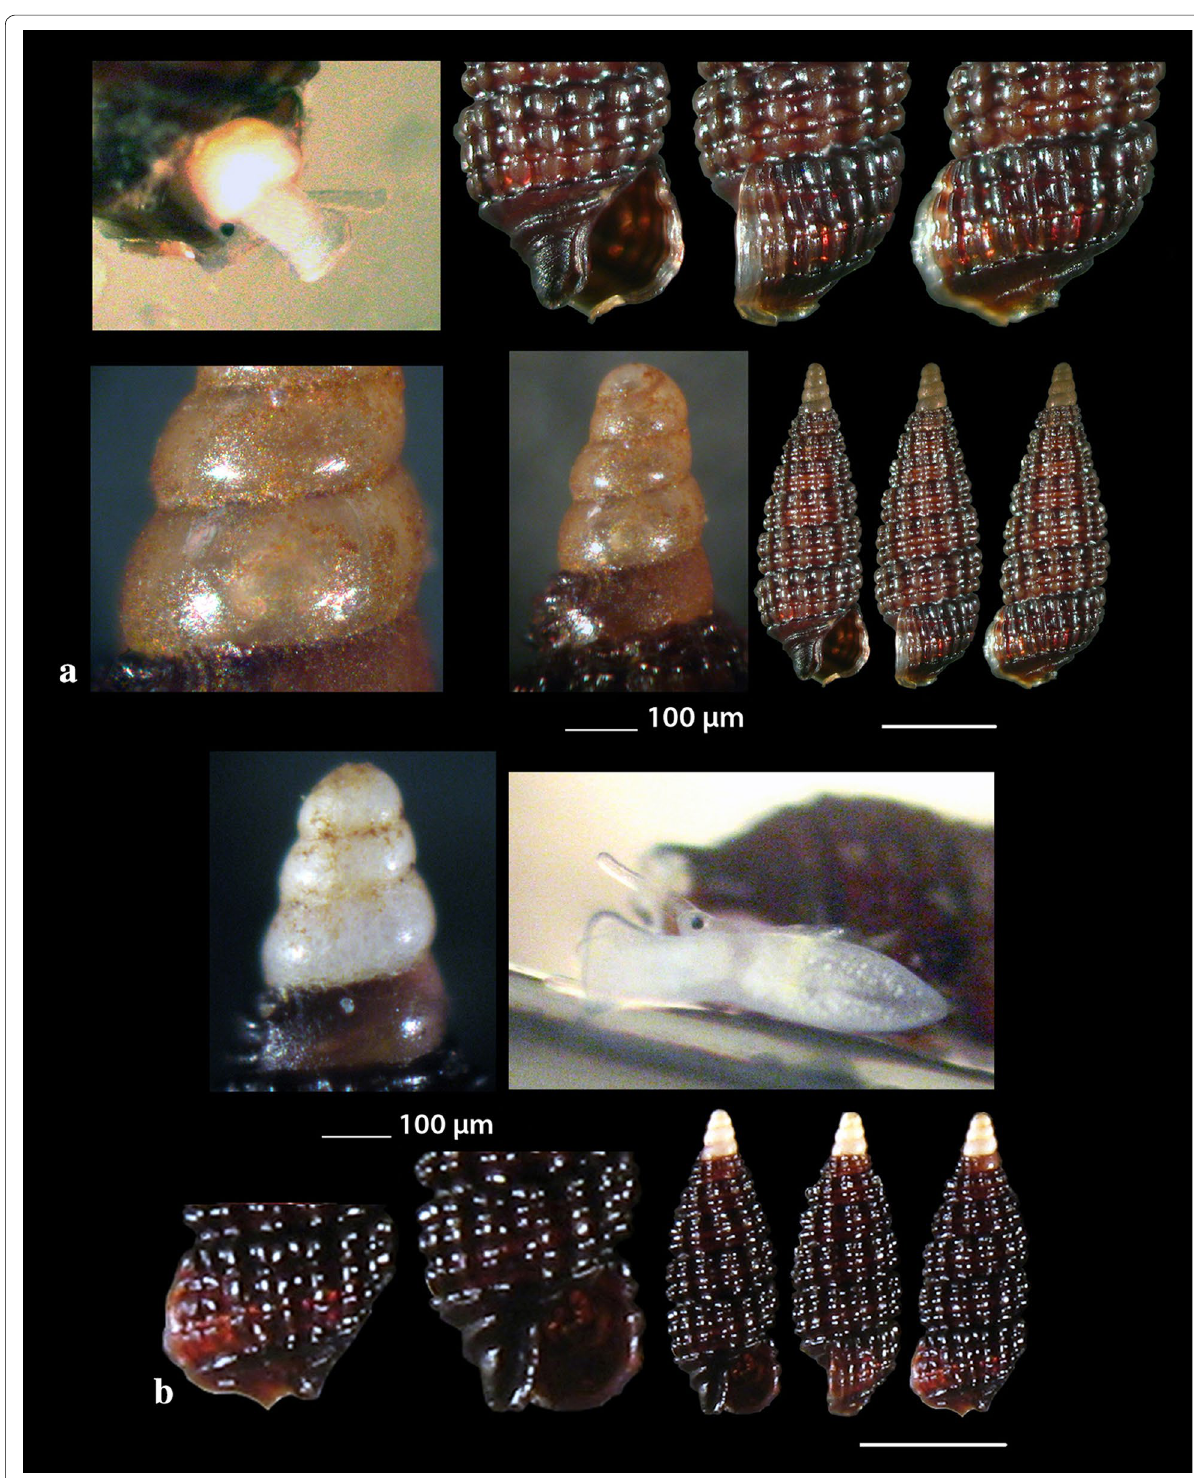
Fig. 9 a Cerithiopsis nana , b Cerithiopsis minima . Bar